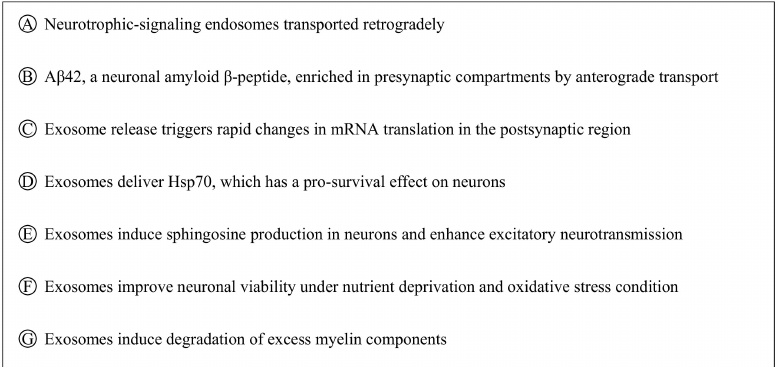
Figure 1. Multivesicular bodies can move retrogradely and anterogradely in neural cells (A-B), which may lead to their release into the extracellular space as exosomes. Exosomes participating in intercellular communication (signaling among neurons and / or non-neuronal cells, C–G) play a critical role in neuronal physiology and